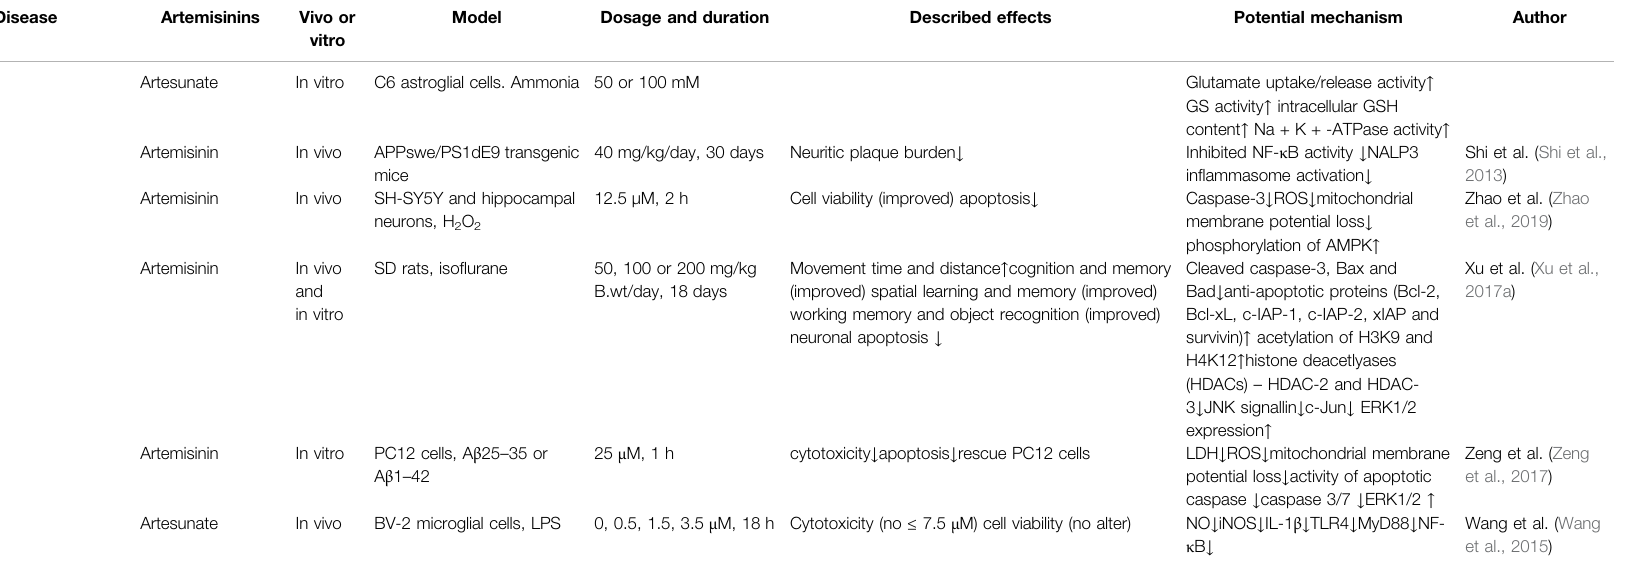
TABLE 2 | ( Continued ) Effects of Artemisinins on T2DM Associated